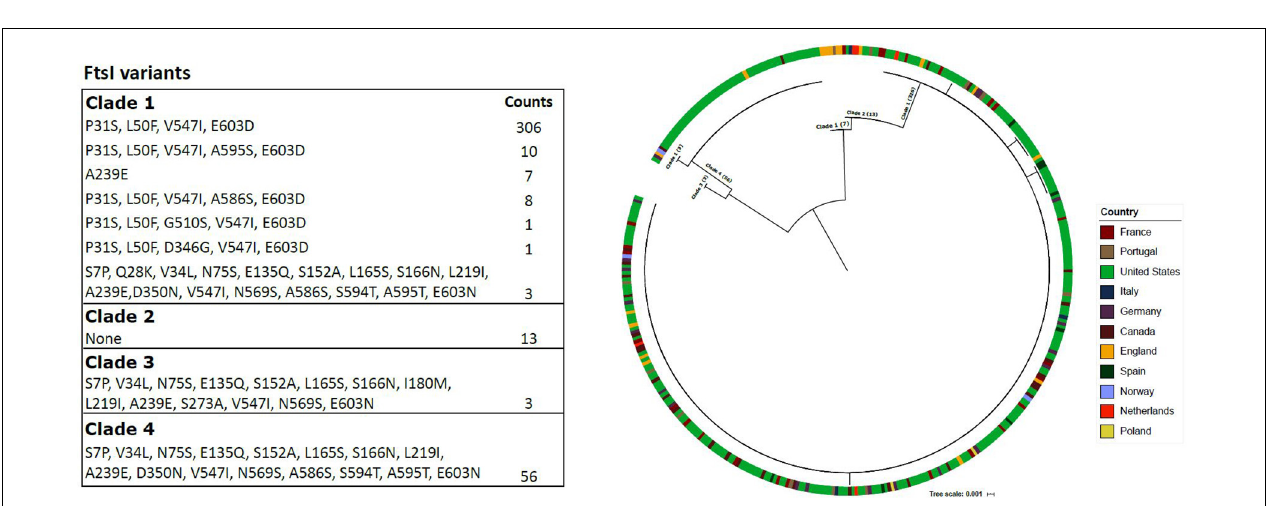
FIGURE 5 | The PBP3 variants are shown in the table for each of the major Hia clades. The phylogeny consists of PBP3 protein sequences and is annotated with the respective country of the isolate. The branches include which of the four major Hia clades the isolates belong